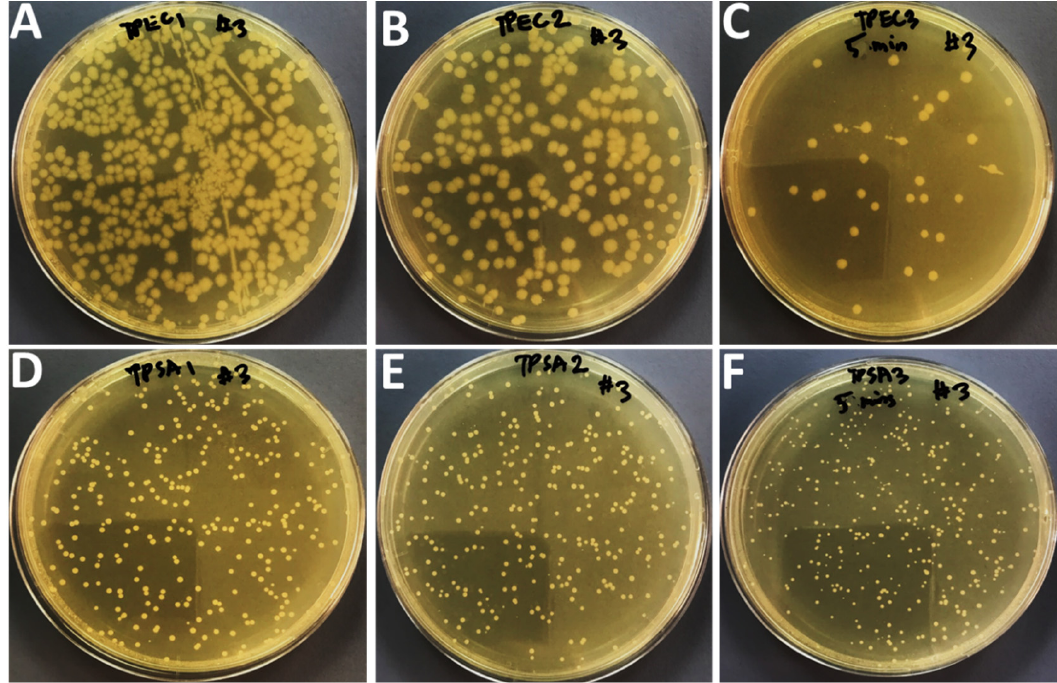
Figure 7. Effects of Ta-Ag 3 PO 4 on the growth of E. coli ( A – C ) and S . aureus ( D –F). ( A , D ); without compound and without sonication, ( B , E ) with compound but without sonication, and ( C , F ); with compound and 5 min of sonication.